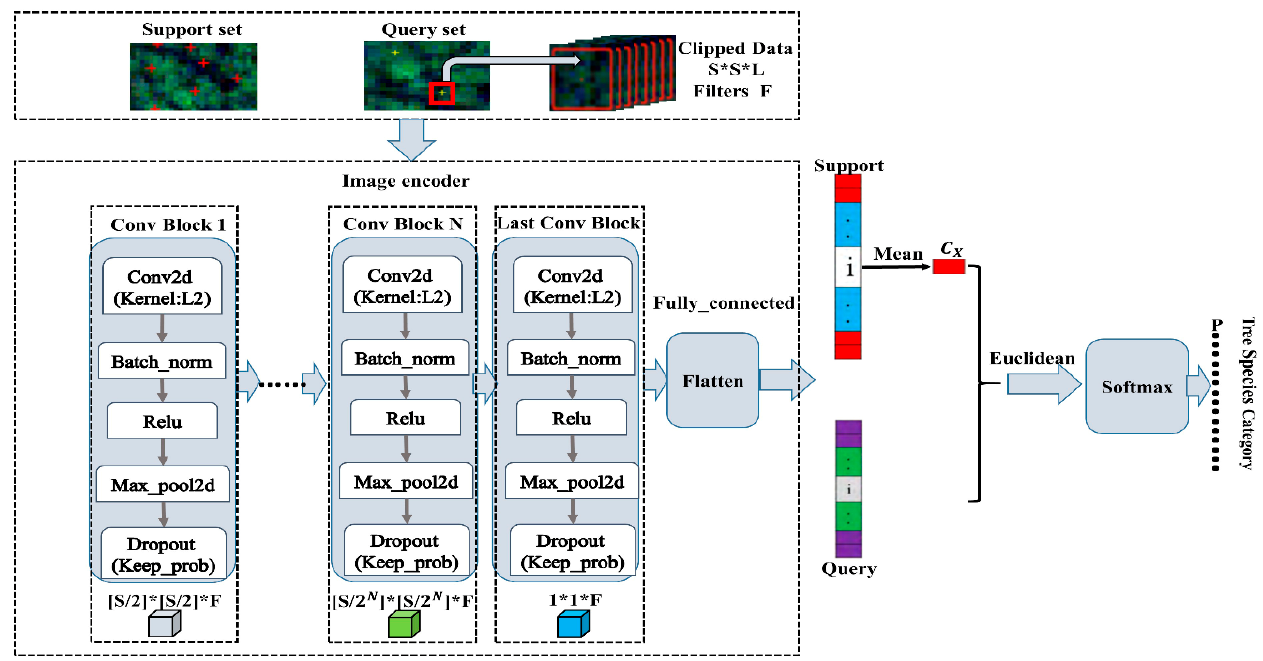
Figure 2. Prototypical networks classification framework.